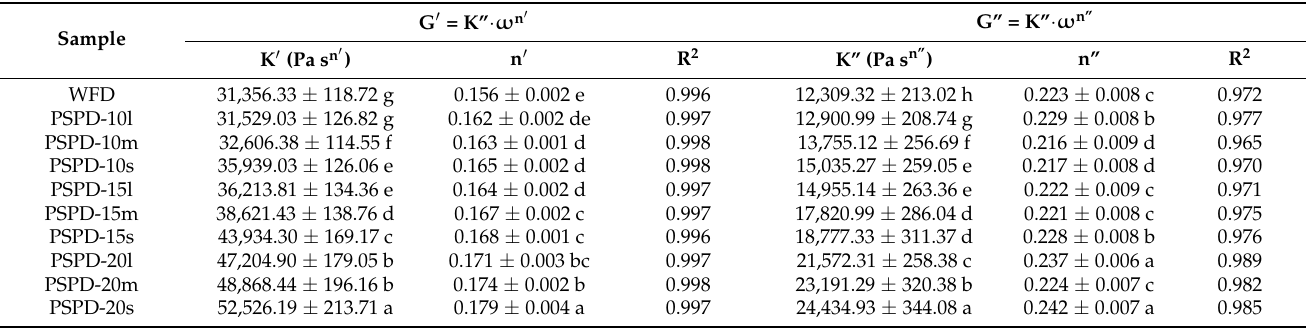
Table 4. Effects of particle sizes and addition levels on power law models in dough frequency scan